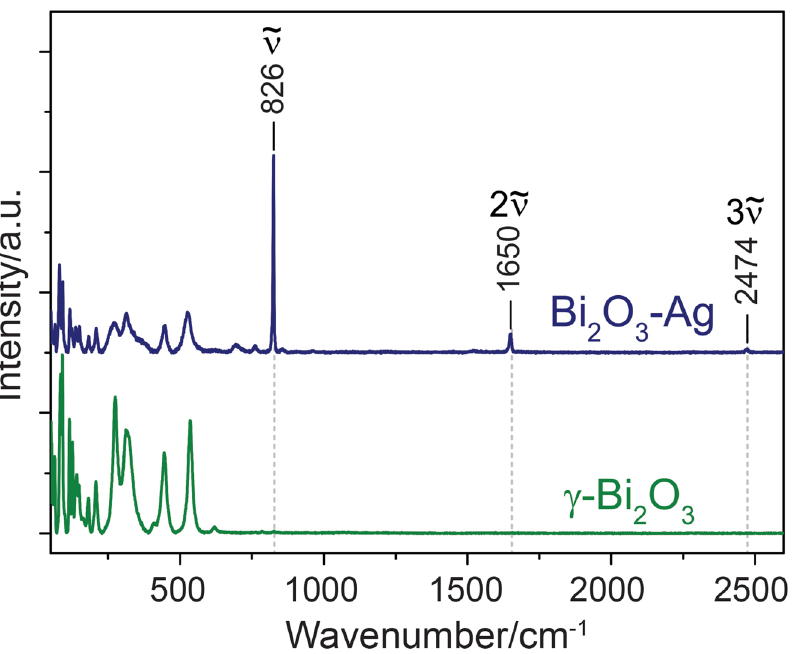
Figure 3: Occurrence of overtones due to the SERS effect in the Bi 2 O 3 -Ag eutectic composite and comparison with the spectrum of the γ -Bi 2 O 3 single crystal. The eutectics ’ spectrum (blue spectrum) reveals overtones ( 2 ˜ v ) and ( 3 ˜ v ) of the 826 cm − 1 band, whereas the single crystal does not exhibit resonant effects (green spectrum), λ exc = 532